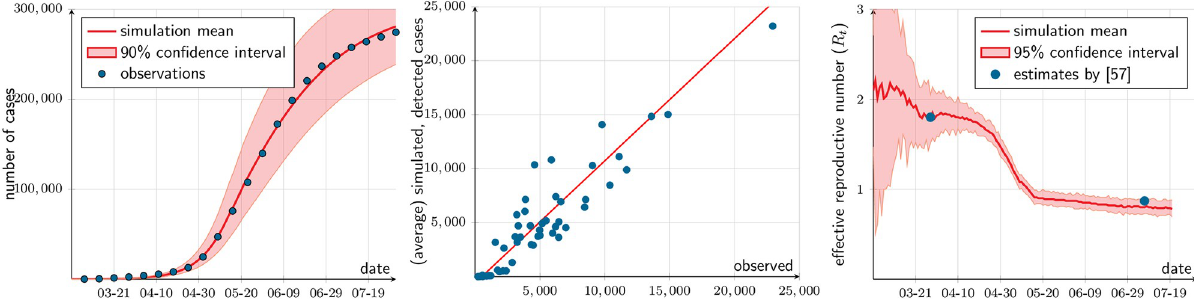
Fig 6. Model fit. (a) Cumulative detected cases: observed vs. simulated, March 1—August 1, 2020. (b) Cumulative detected cases by August 1, 2020, by municipality: observed vs. simulated. (c) Effective (case) reproductive number ( R t ).